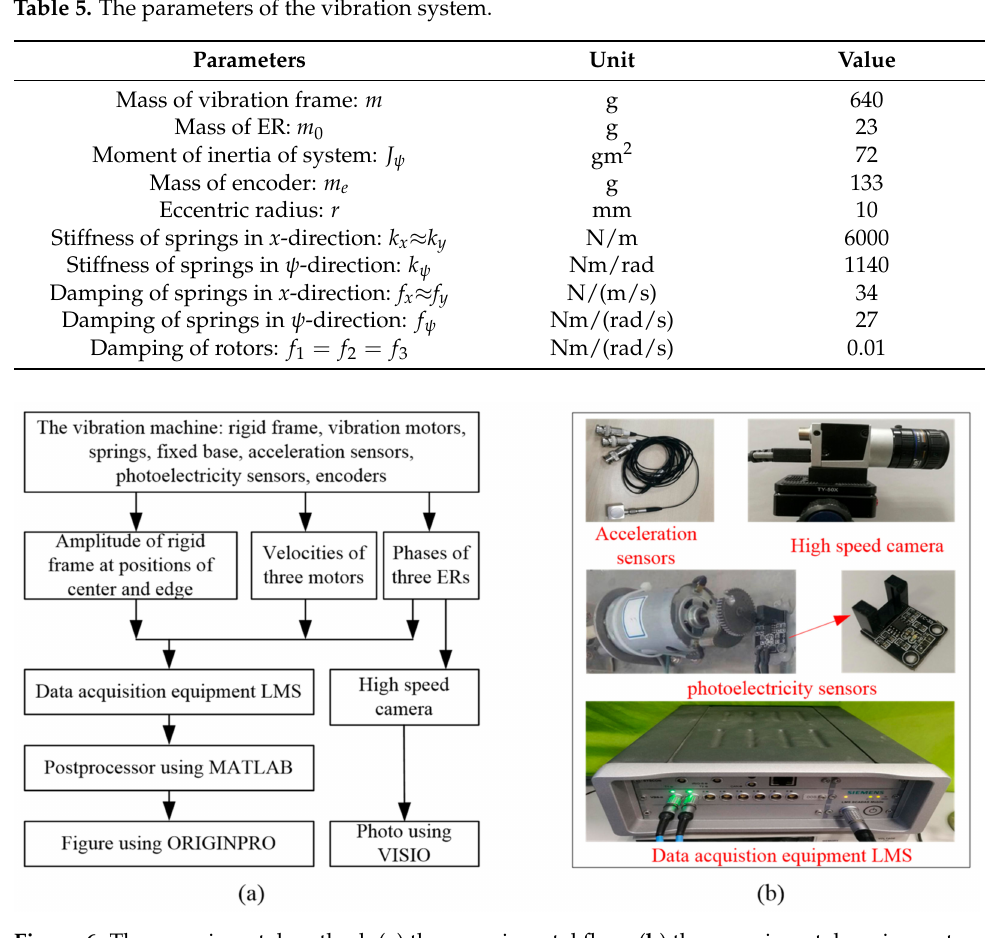
Figure 6. The experimental method: ( a ) the experimental flow; ( b ) the experimental